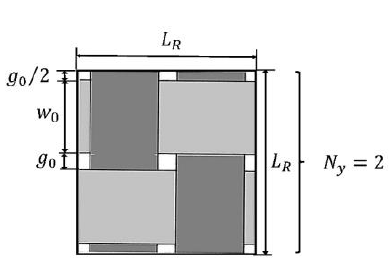
Figure 1. Geometry of a plain-woven RVE.